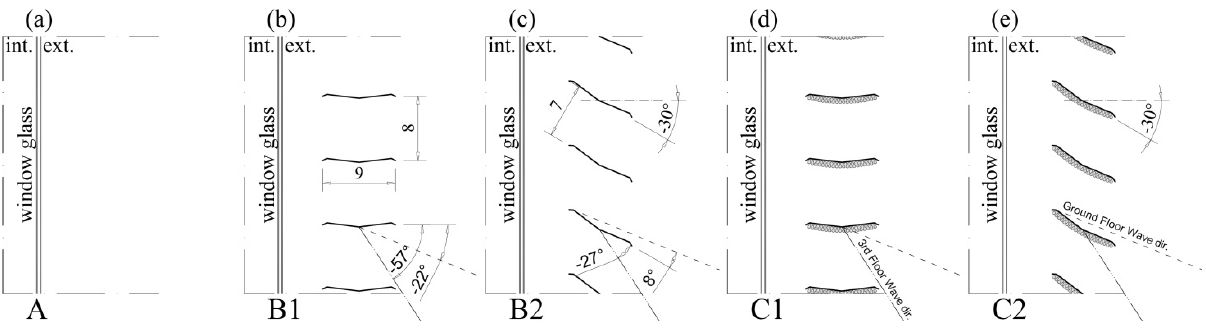
Figure 3. Different louver configurations. ( a ) A: window without louvers; ( b ) B1: window with 0° tilt standard louvers; ( c ) B2: window with − 30° tilt standard louvers; ( d ) C1: window with 0° tilt louvers with sound absorbing material; ( e ) C2: window with − 30° tilt louvers with sound absorbing material. Main directions of sound waves are highlighted for ground and third floors (see further Section 2.1.3). Dimensions are in cm.